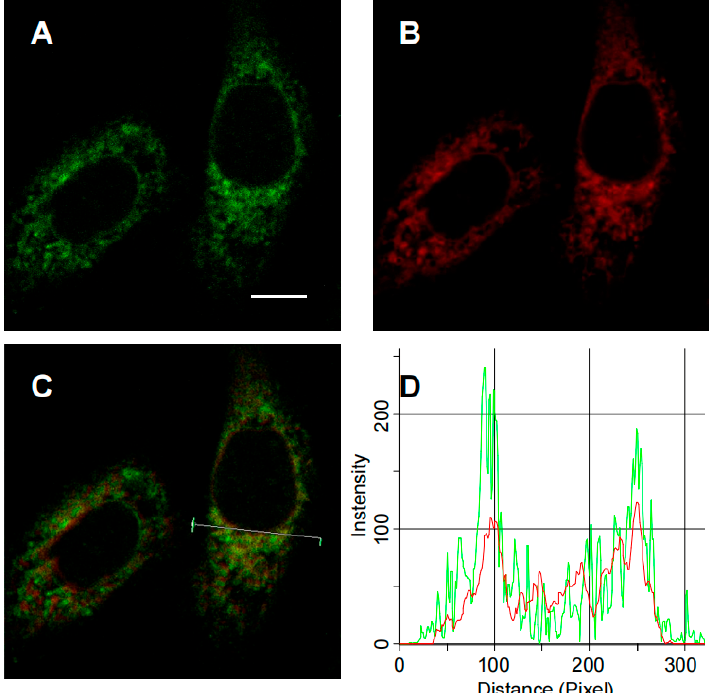
Figure 3. ( A ) Two-photon confocal fluorescence images of CYP1A in A549 treated with ERNM at the channel 520–560 nm; ( B ) ER-Tracker; ( C ) merge image; ( D ) fluorescence intensity for the region of interest (line in panel ( C )), the green line represented the fluorescence intensity for ERNM and the red line represented the fluorescence intensity for ER-Tracker. Scale bar is 10 μ m, as shown in panel A.